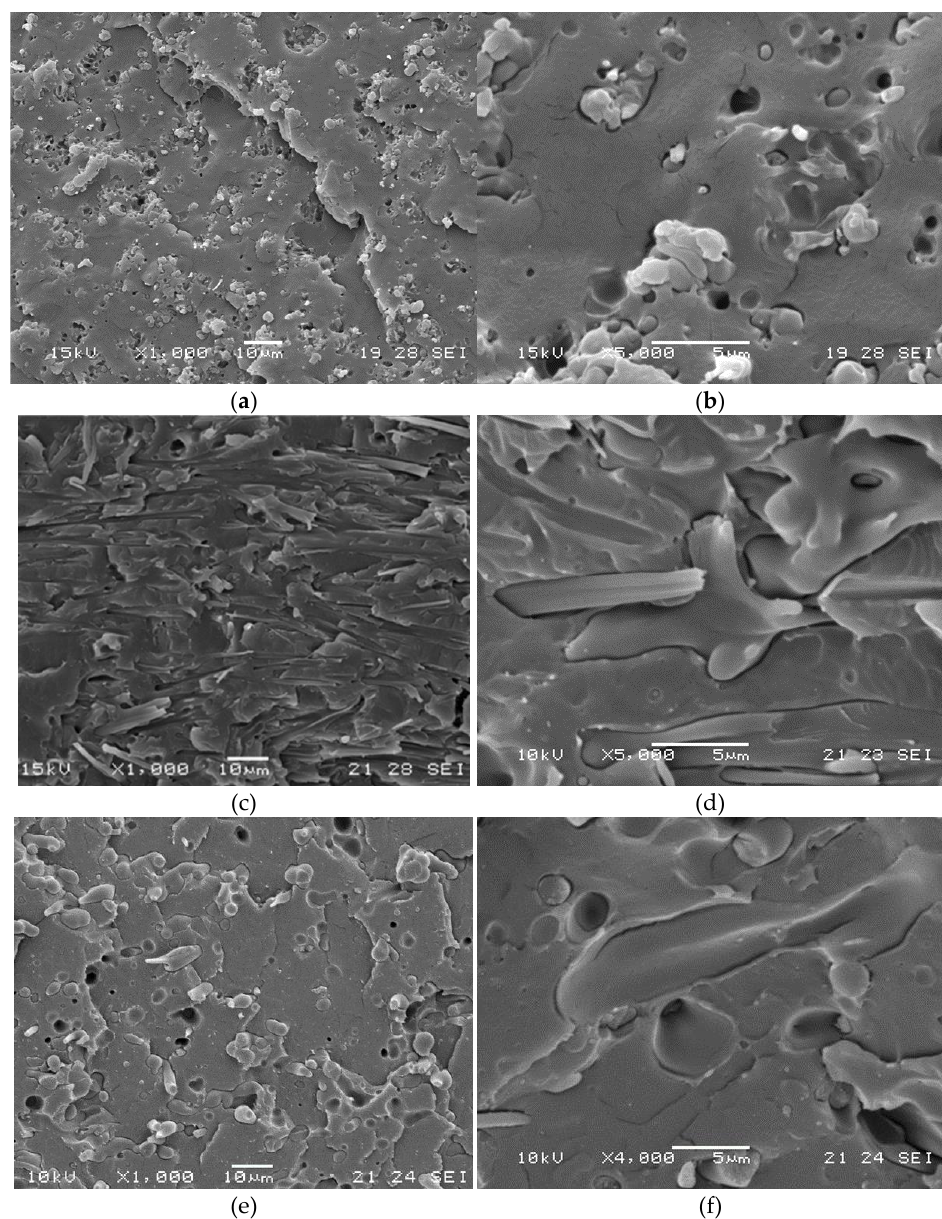
Figure 8. SEM micrographs obtained on cryo-fractured blends of samples PLA75/pAC25_C1 and PLA75/pAC25_C2 compounded at 230 °C: ( a ) PLA75/pAC25 at 1000x magnification; ( b ) PLA75/pAC25 at 5000× magnification; ( c ) PLA75/pAC25_C1 at 1000× magnification; ( d ) PLA75/pAC25_C1 at 5000× magnification; ( e ) PLA75/pAC25_C2 at 1000× magnification; ( f ) PLA75/pAC25_C2 at 4000× magnification.